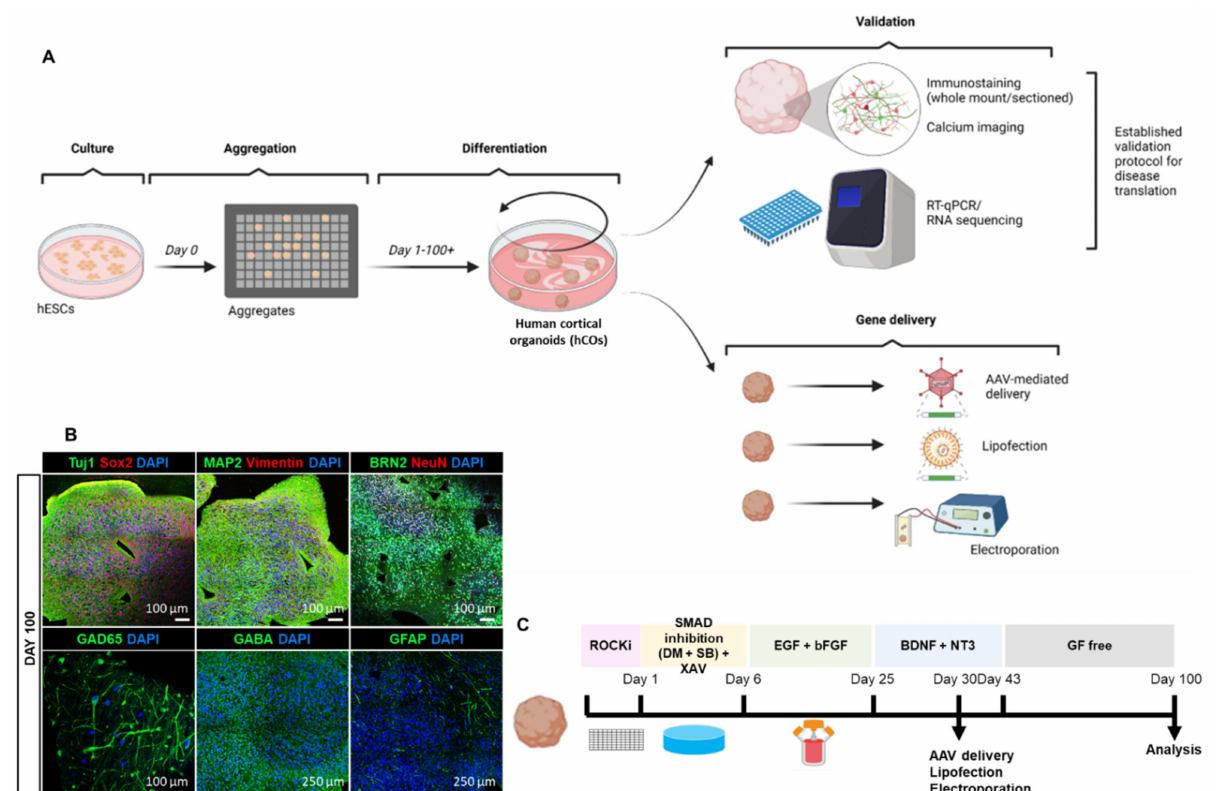
Figure 1. Establishment of hESC-derived cortical organoid. ( A ) Schematic illustration showing establishment of cortical organoid and gene delivery approaches. ( B ) Paraffin-sectioned immunohis- tochemical staining of cortical organoid at day 100 with antibodies for stemness (SOX2), neuronal (TUJ1, MAP2, NeuN), radial glial (VIM), cortical layer (BRN2), excitatory (GLUT1), and inhibitory neurons (GAD65, GABA) as well as astrocyte (GFAP). ( C ) Timeline of growth factor induction, gene delivery (i.e., Adeno-associated virus (AAV), lipofection, electroporation) and analysis of cortical organoid. Scale bars as indicated in the